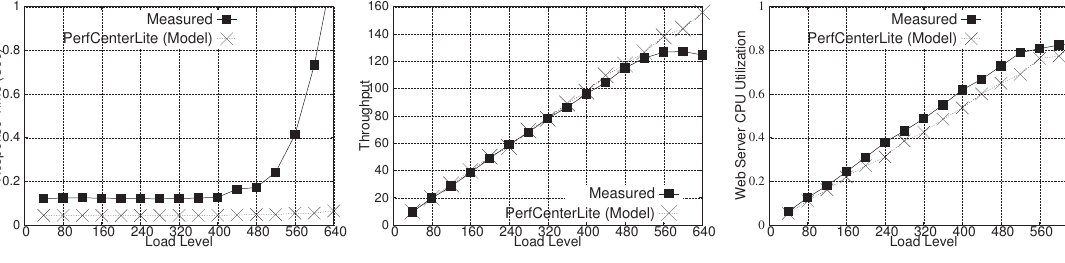
Figure 4: Measured vs Modeled Performance Metrics Validation for scale-out deployment (Experiment 2)